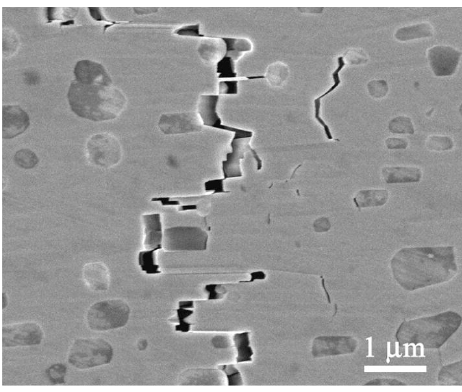
Figure 6. SEM micrographs of the in situ crack propagation of textured Nb 4 AlC 3 [40].